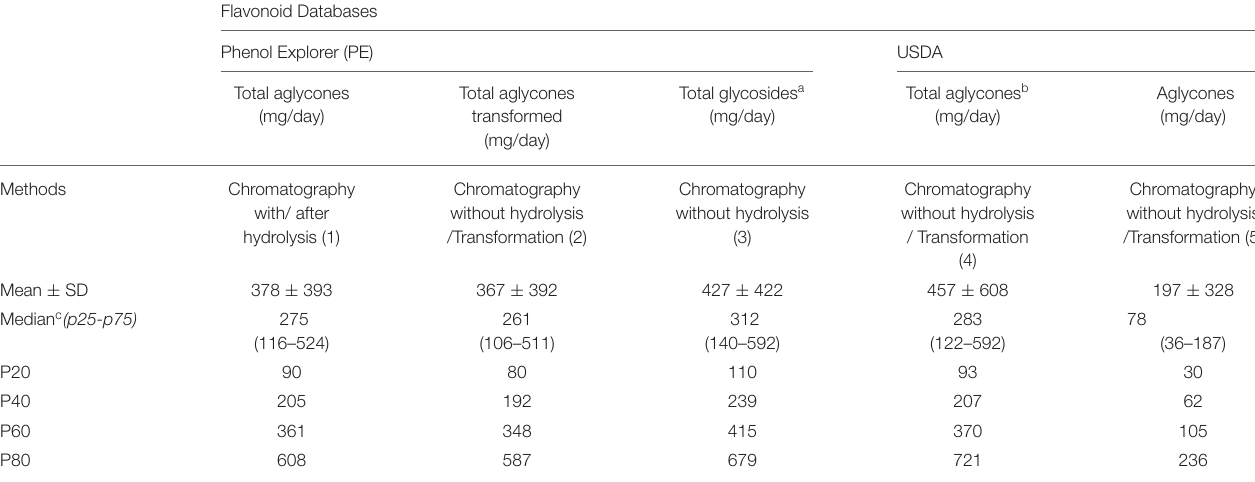
TABLE 1 | Total flavonoids content by polyphenol databases and the methods of estimation used in MAX